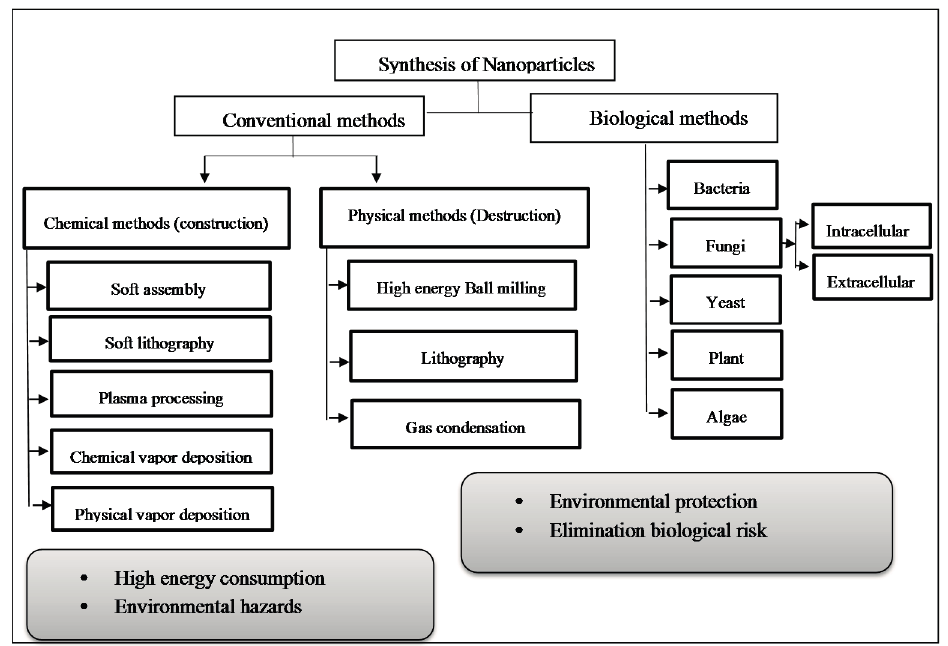
Scheme 1. Different synthetic approaches of metallic nanoparticles.